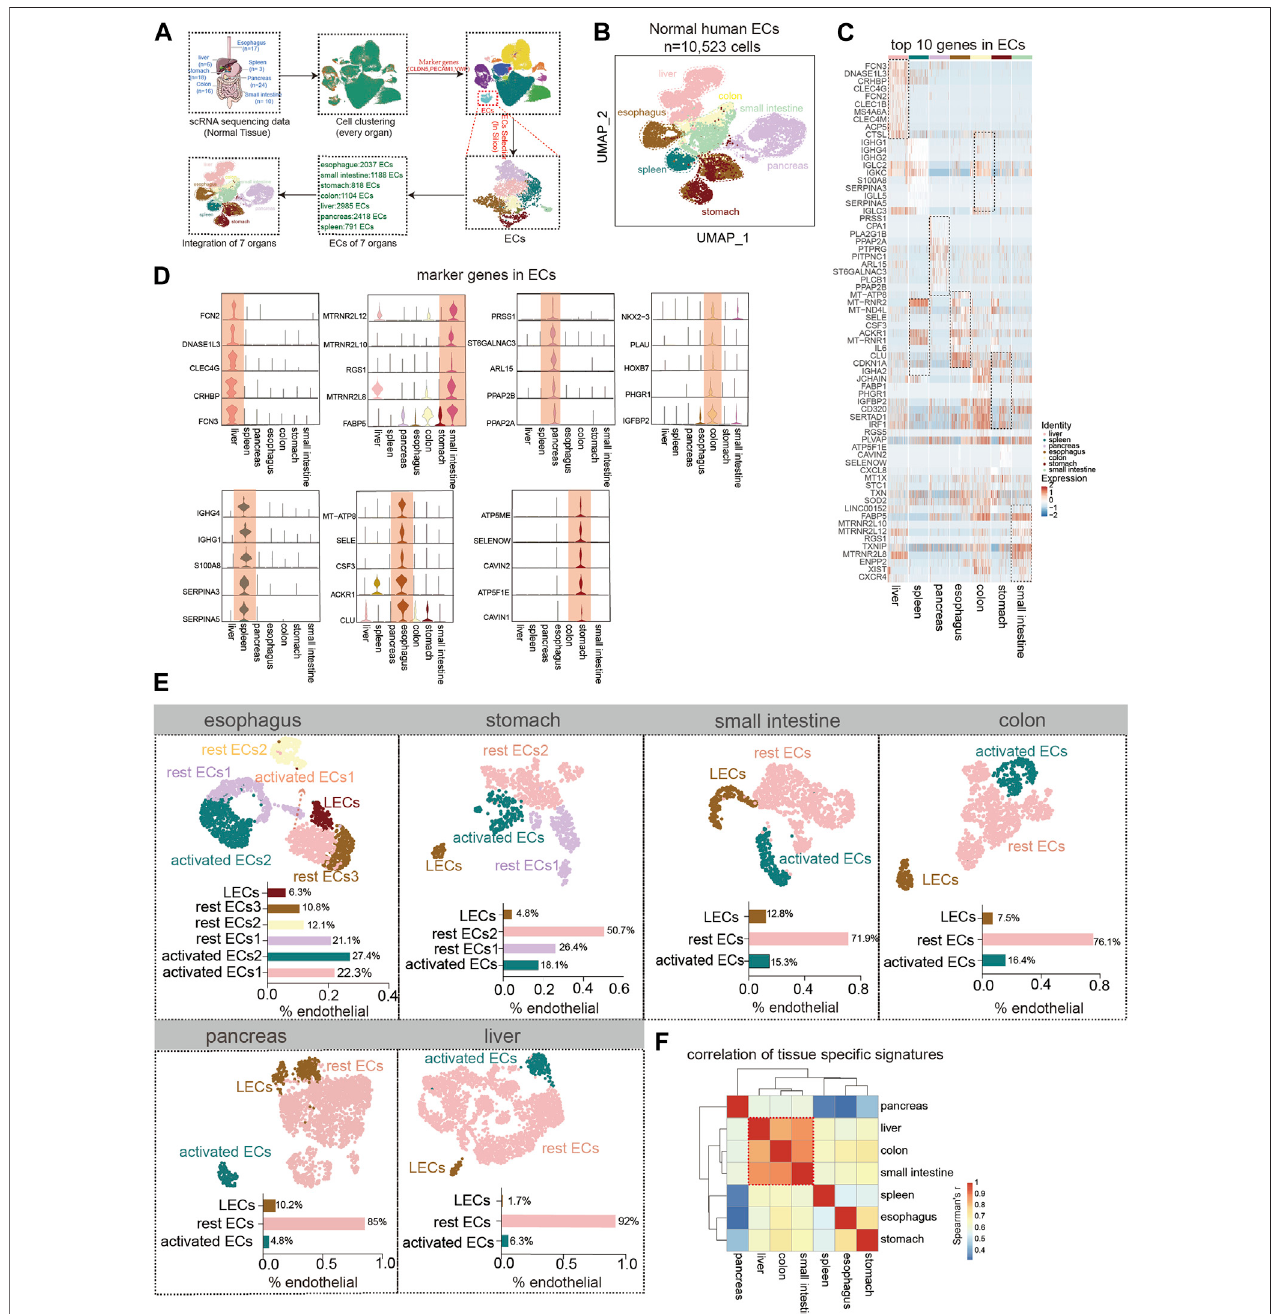
FIGURE 1 | Tissue-speci fi c heterogeneity of endothelial cells (ECs). (A) Scheme of in silico -selected ECs in this study design. (B) Uniform manifold approximation and projection (UMAP) representation ofthe different digestivetissuesfrom a cell dataset of 10,523 ECs from 93 normal humans (esophagus ( n = 2,037 cells), stomach ( n =818 cells),smallintestine ( n =1,188 cells),colon ( n = 1,104 cells),liver ( n = 2,985 cells),pancreas ( n = 2,418cells), and spleen( n =791 cells)). Different colorscoded to identify the tissue type (see also Supplementary Table S1 ). (C) Heat map of the top 10 marker genes expressions for each ECs. Color scale: red, high expression; blue, low expression. (D) Violin plot showing the high expression of endothelial marker genes in different tissues. (E) UMAP plot of esophageal EC subpopulation analysiswith cell types classi fi edas activated EC1 (22.3%), activated EC2 (27.4%),rest EC1 (21.1%), rest EC2 (12.1%), rest EC3 (10.8%), and lymphatic ECs (6.3%). The stomach ECs: activated ECs (18.1%), rest EC1 (26.4%), rest EC2 (50.7%), and lymphatic ECs (4.8%). The small intestinal ECs: activated ECs (15.3%), restECs (71.9%),andlymphaticECs (12.8%).ThecolonicECs:activated ECs(16.4%),restECs (76.1%),andlymphaticECs(7.5%).Thepancreatic ECs:activatedECs (4.8%), rest ECs (85%), and lymphatics ECs (10.2%). The hepatic ECs: activated ECs (6.3%), rest ECs (92%), and lymphatics ECs (1.7%). (F) Heat map showing the correlation analysis of gene expression in subpopulations of ECs in each organ.